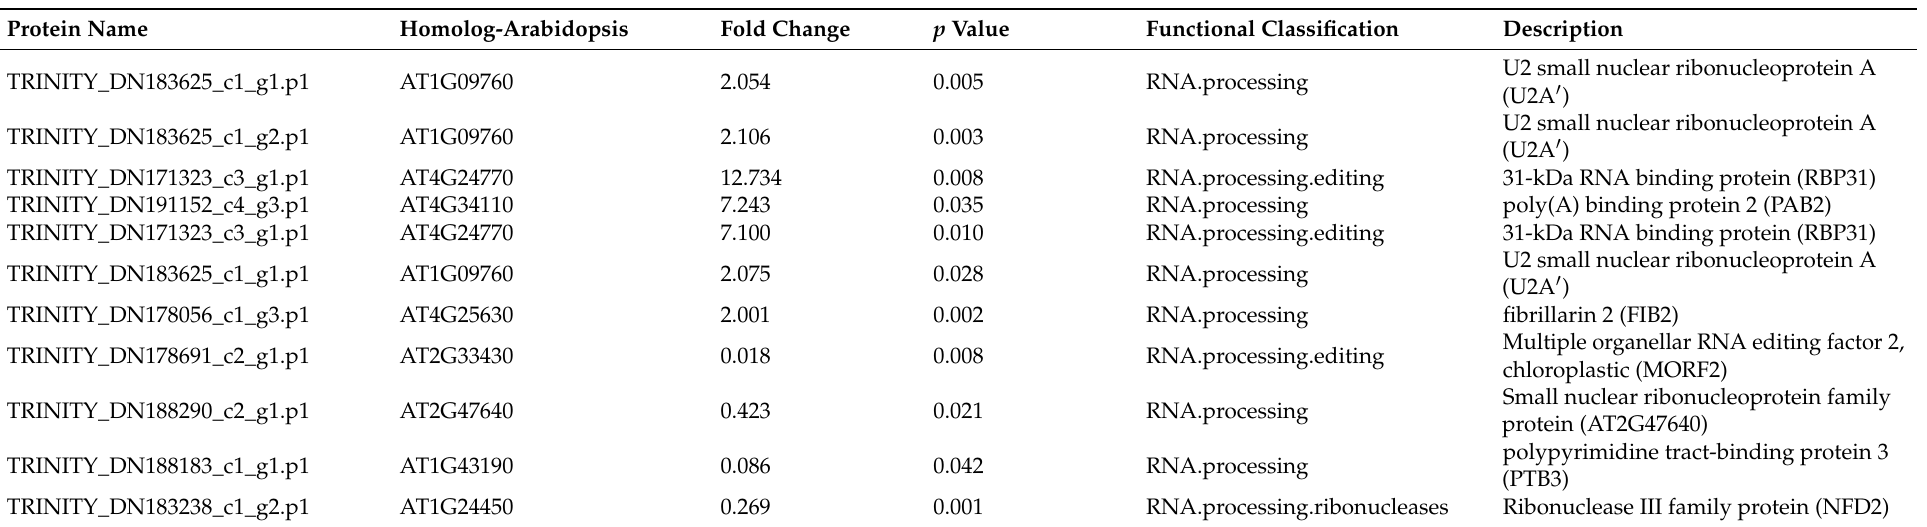
Table 2. List of RNA processing-related proteins in